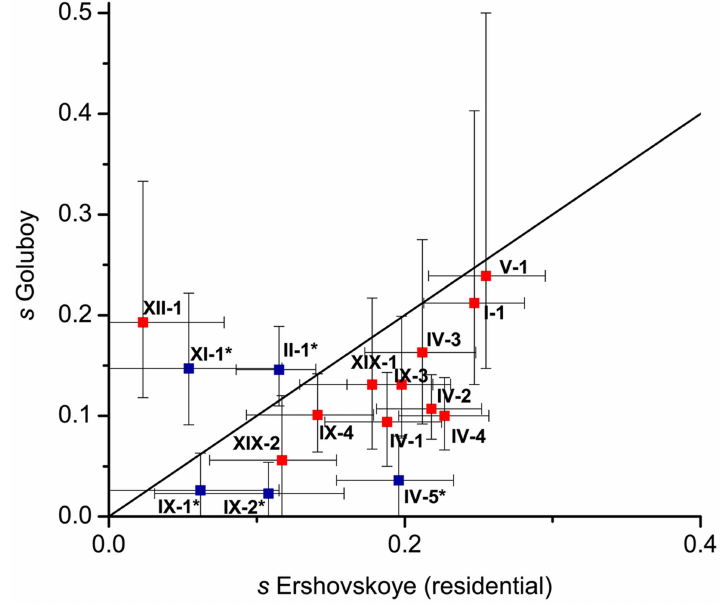
Figure 5. Selection coefficients at DIs estimated from Lake Ershovskoye and Quarry Goluboy. Red, DIs identified under the strong criterion; blue, DIs identified under the weak criterion. Three DIs are not shown: VII-1 and XXI-1, which had inferred s below 0 in one of the populations; and XII-2, for which s at Quarry Goluboy could not be inferred reliably due to near-fixation of the freshwater allele (Table 2). Whiskers correspond to values of s inferred from mean 6 st. dev. of allele frequency